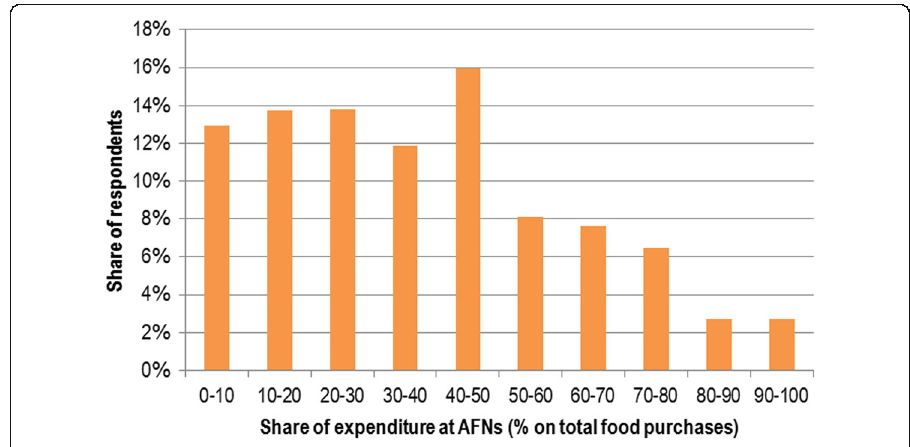
Fig. 2 Distribution of observations per share of expenditure at AFNs